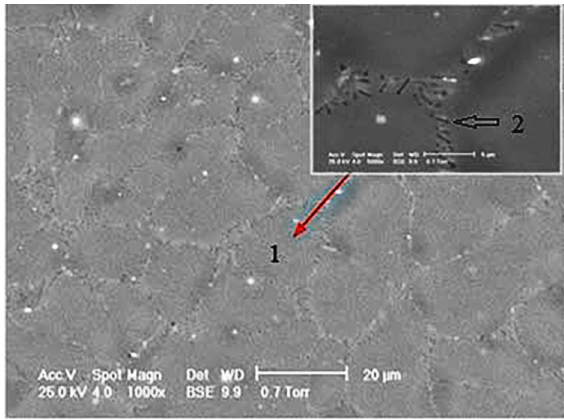
Figure 11. Mg-1Ca SEM image, before immersion.